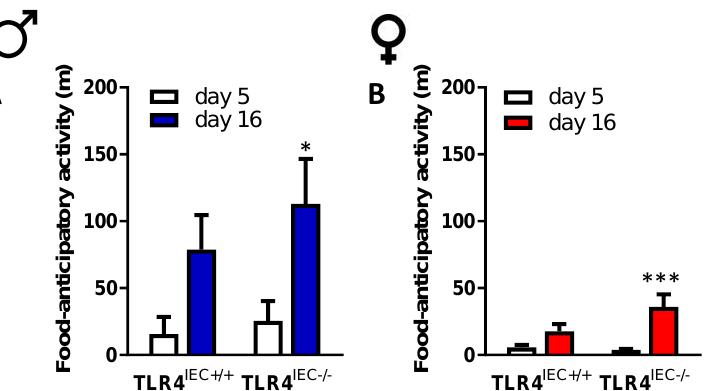
Figure 4. Food-anticipatory activity between d5 and d16 in ABA TLR4 IEC+/+ and TLR4 IEC − / − in male and female mice. Food-anticipatory activity between d5 (open bars) and d16 (blue bars) in ABA TLR4 IEC+/+ and TLR4 IEC − / − male mice ( A ). Food-anticipatory activity between d5 (open bars) and d16 (red bars) in ABA TLR4 IEC+/+ and TLR4 IEC − / − female mice ( B ). The results of the Bonferroni post hoc tests are shown: *, p < 0.05 and ***, p < 0.001 vs. CT.